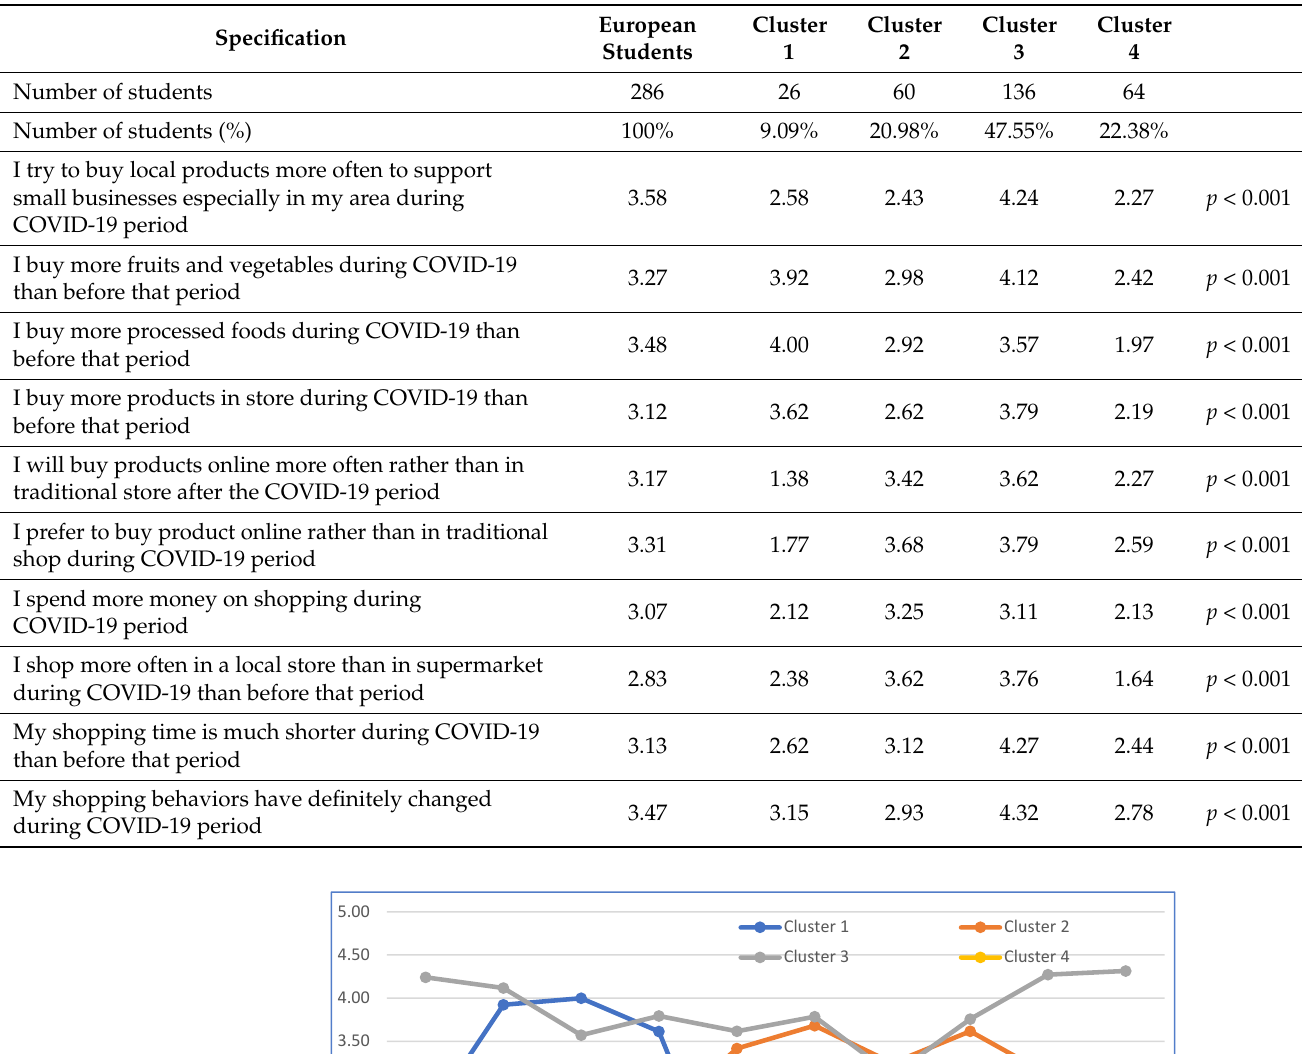
Table 7. Cluster analysis: European students.